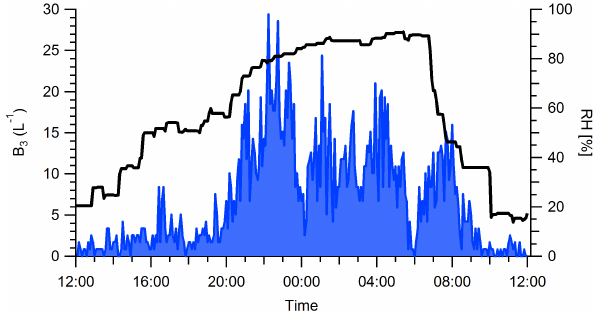
Figure 13. RH (right) and associated B 3 concentration (left) for Fig. 13. RH (right) and associated B 3 concentration (left) for a dry a dry 24h period starting 12:00 27 July 24 hour period starting 12:00 27 July 2013.